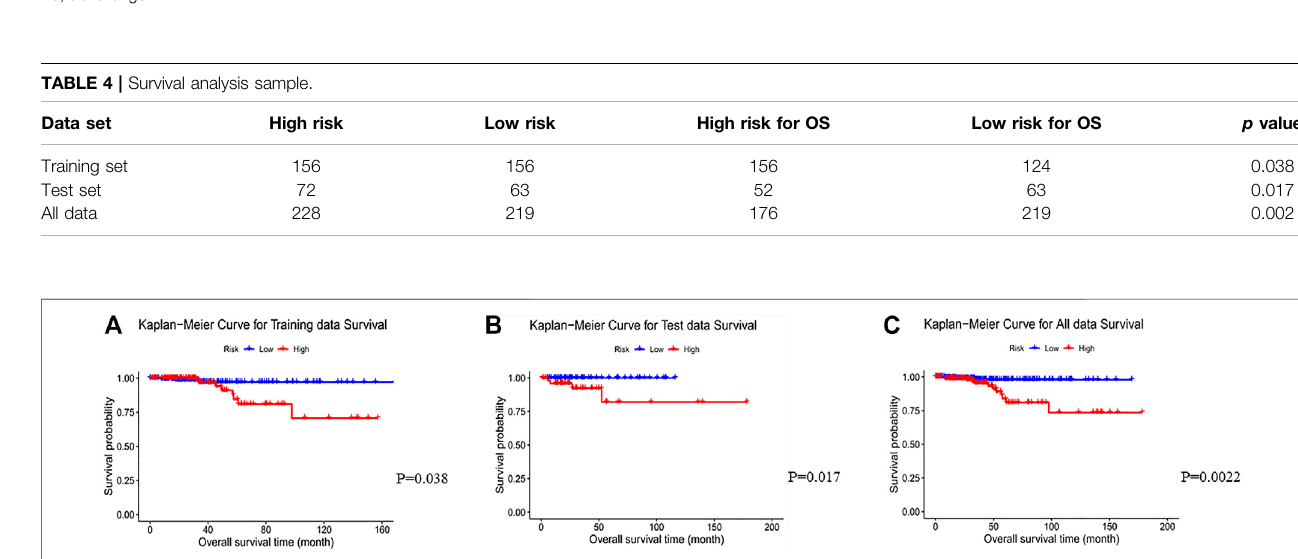
FIGURE 3 | Kaplan-Meier curves for the low- and high-risk groups separated by the Risk-Score of the 3-gene signature in the TCGA PTC data. The blue line represents the patients with low risk and the others represent patients with high risk. Signi fi cant differences in overall survival between the two groups were analyzed by log-rank test. (A ) Kaplan-Meier curves for training data survival; (B) Kaplan-Meier curves for test data; (C) Kaplan-Meier curves for all